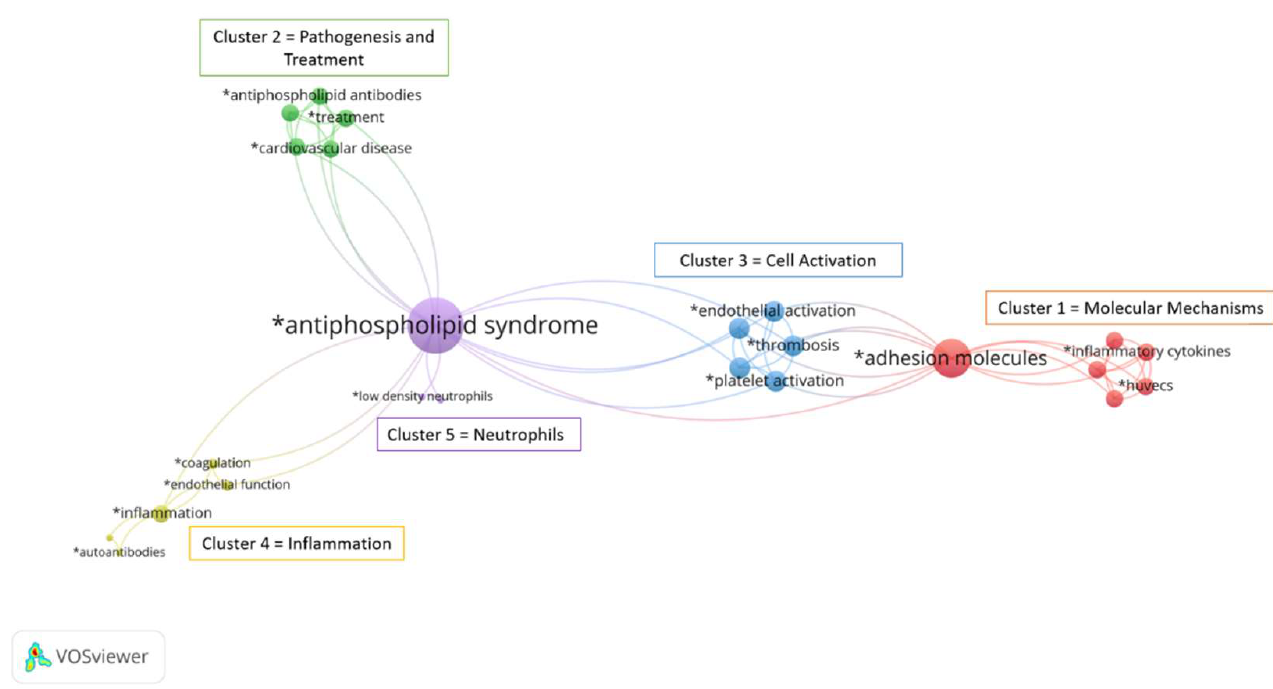
Figure 2. A bibliometric analysis of the published literature on adhesion molecules and APS using VOSviewer software . Mapping of keywords of studies pertaining to “adhesion molecules” and “APS” categorized into five clusters (molecular mechanisms, pathogenesis and treatment, cell activation, inflammation, and